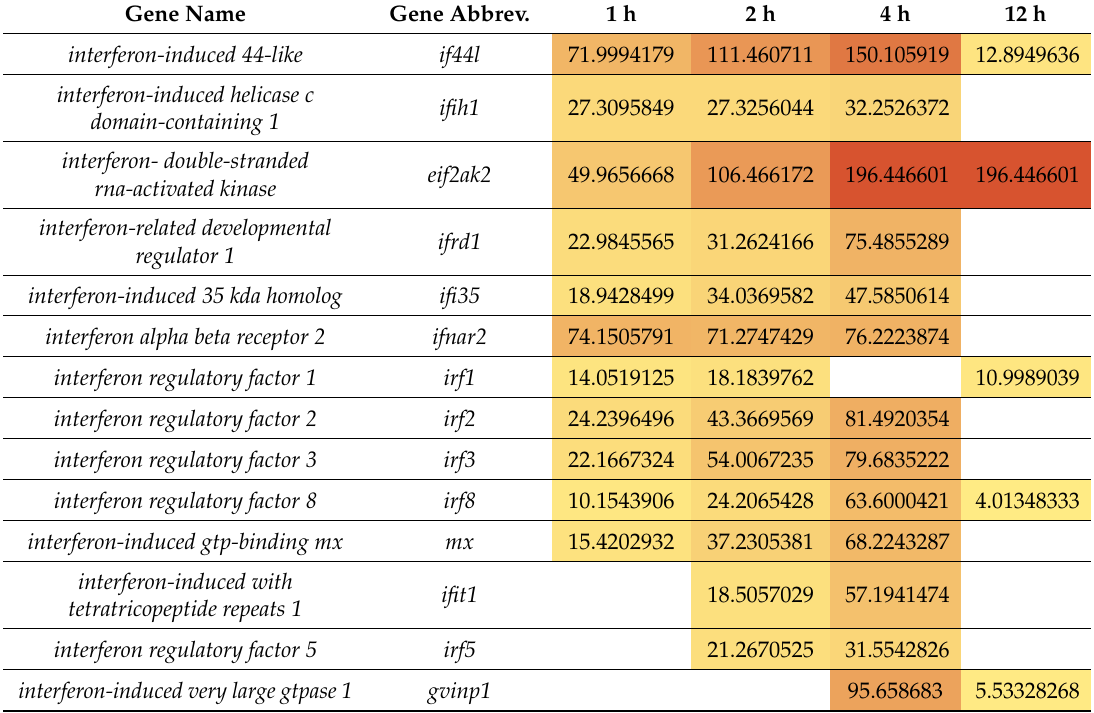
Table 6. Heat map showing a group of DE genes in turbot peritoneal cells at 1, 2, 4 and 12 hpi, including several interferon regulatory factor genes. Results are expressed as mean expression ratios of groups 1, 2 and 4 hpi vs. 0 h, or 12 hpi vs. PBS. There were no DE genes at 48 hpi. Red indicates increased gene expression levels; green indicates decreased